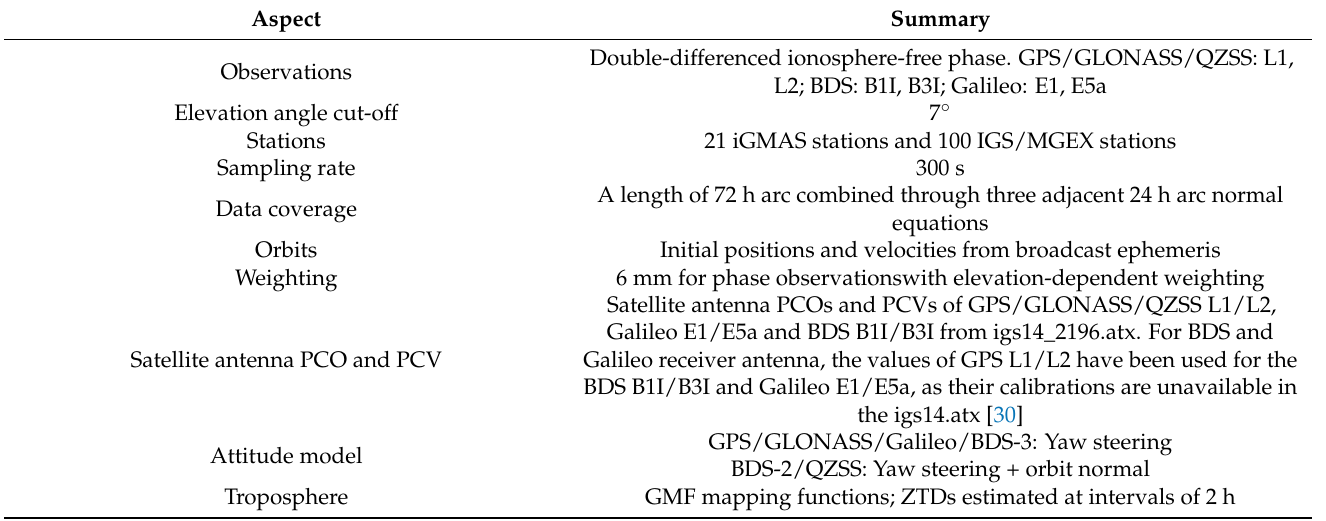
Table 3. Outline of the ultrarapid POD strategy for multi-GNSS.